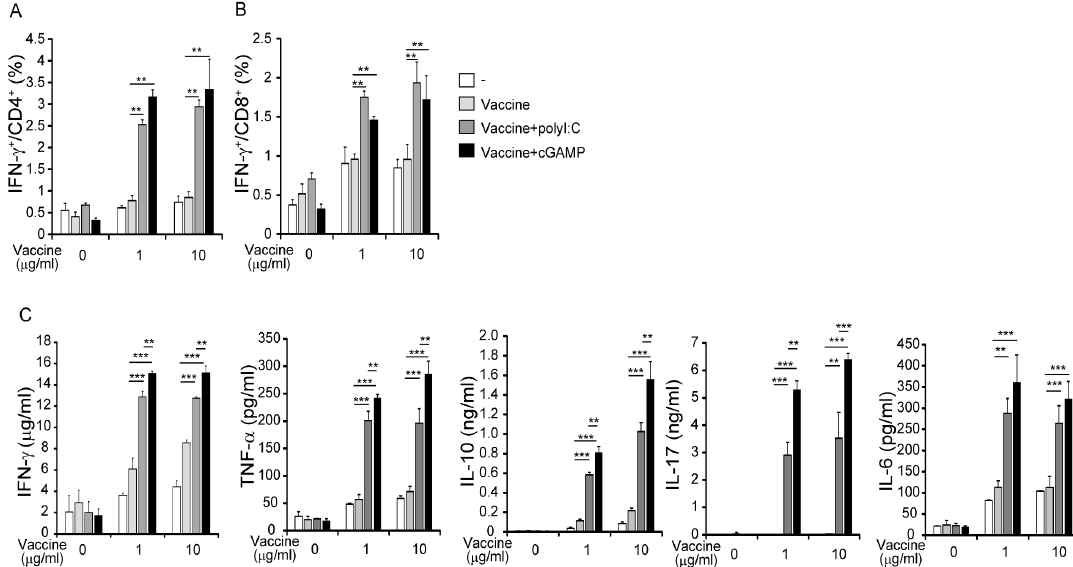
Figure 2. cGAMP-enhanced antigen-specific T-cell responses. WT mice were i.n. vaccinated twice and splenocytes (1 × 10 6 cells) were re-stimulated by 0–10 µ g/mL of split-HA vaccine for 3 days. Cells were incubated with brefeldin A during the last 6 h of culture and stained with PE-Cy7-labeled anti-CD3, FITC-labeled anti-CD4, PE-labeled anti-CD8 and APC-labeled anti-interferon (IFN)- γ Abs. The percentages of IFN- γ -producing CD3 + CD4 + T-cells and CD3 + CD8 + T-cells are shown in ( A , B ). ( C ) The levels of IFN- γ , interleukin (IL)-6, IL-10, IL-17, and tumor necrosis factor (TNF)- α production in culture supernatants were determined by cytometric bead array (CBA) assay. The values are presented as the mean ± standard deviation (SD) of 3 samples for each group. ** p < 0.01; *** p < 0.001 in the Mann-Whitney U test. One representative experiment out of three is shown.